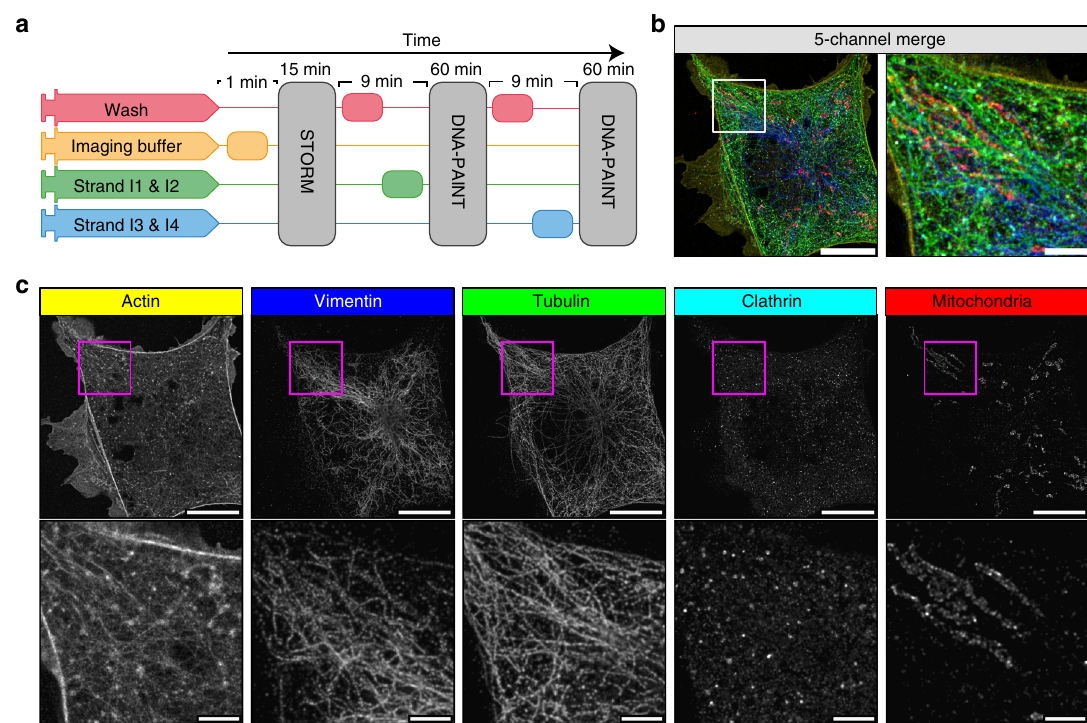
Fig. 5 Automated DNA-PAINT and STORM imaging. a NanoJ-Fluidics work fl ow used for STORM and DNA-PAINT imaging. b Left, full view showing 5- channel merge of STORM and DNA-PAINT with actin (yellow, Phalloidin-ATTO488), vimentin (blue, Cy3B DNA-PAINT imager strand), β -tubulin (green, ATTO655 DNA-PAINT imager strand), clathrin (cyan, Cy3B DNA-PAINT imager strand) and mitochondria (red, ATTO655 DNA-PAINT imager strand). Right, zoom of the boxed area. c Single-channel image of each imaged target (top), with insets (bottom) showing a zoom of the boxed area. A movie corresponding to this experiment is available as Supplementary Movie 4. Scale bar corresponds to 10 μ m for full images and 2 μ m for